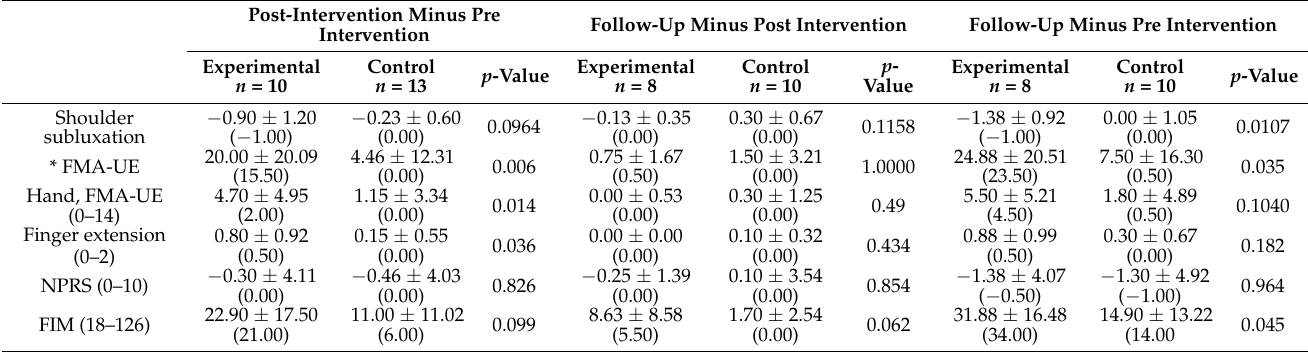
Table 3. Comparison of the delta scores (post-intervention score minus pre-intervention score (T 1 − T 0 ), follow-up score minus post-intervention score (T 2 − T 1 ), follow-up score minus pre- intervention score (T 2 − T 0 ) between groups; mean ± standard deviation (median)) and Wilcoxon two-sample test